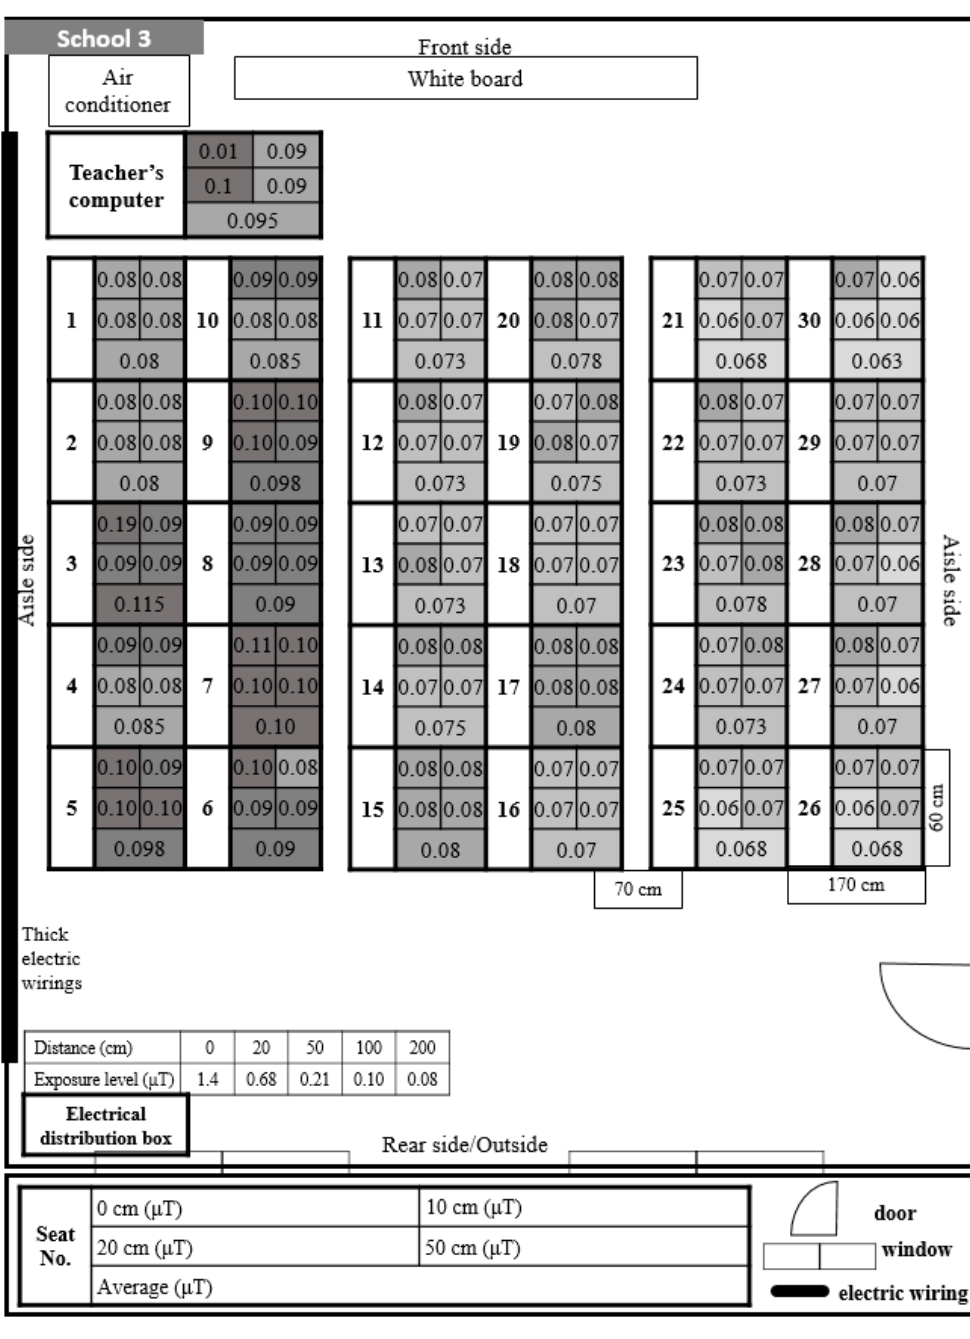
Figure 4. Distribution and exposure level of extremely low-frequency magnetic fields at each student seat in School 3. 0.01 is the lowest readout level, indicating < 0.01. The darkening of the space indicates that the level of ELF-MFs exposure increase by 0.01.